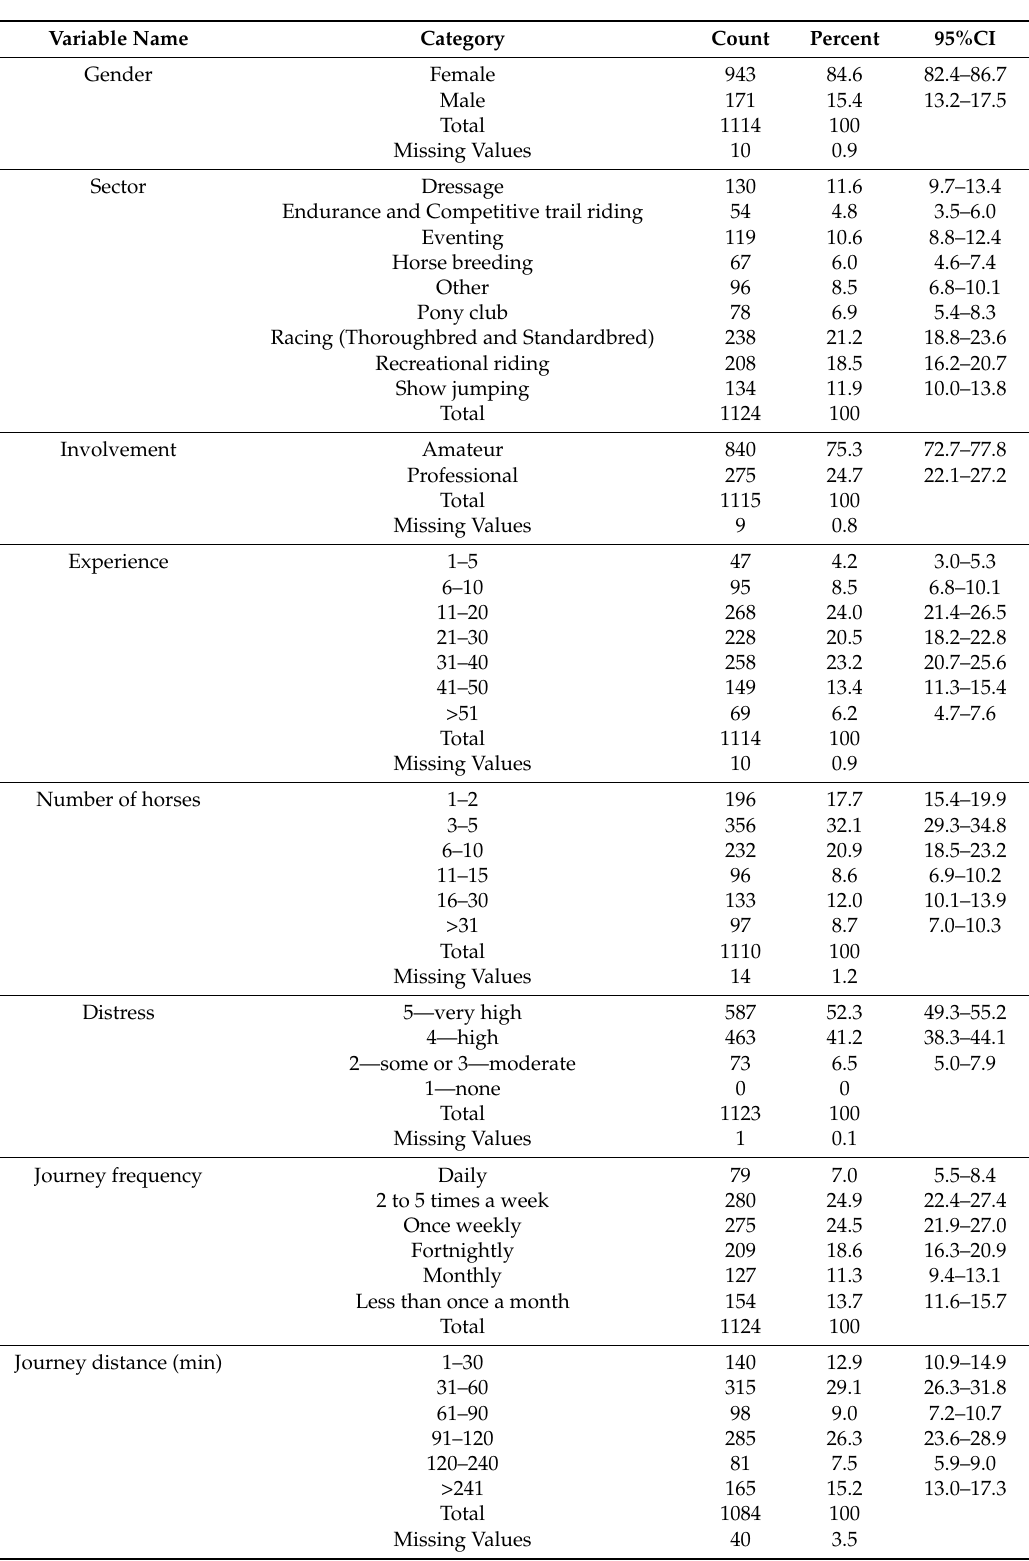
Table 3. Frequency table of the responses to a survey on horse road transport-related problems behaviors in New